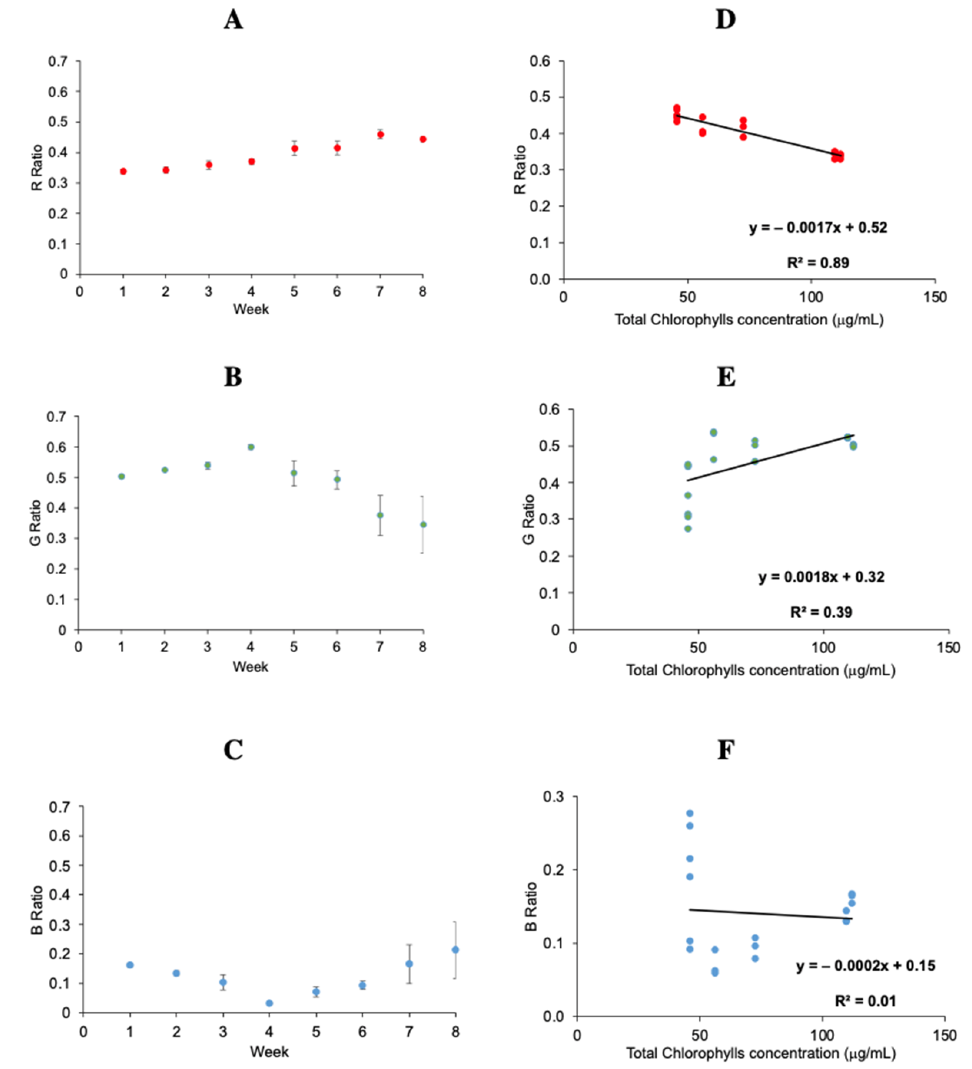
Figure 2. Evolution of the R, G and B ratios along the maturation stage ( A – C ) (mean ratio was obtained considering three replicates of samples (and three images per sample); and linear regression curves for R, G and B ratios and total chlorophyll concentration ( D – F ) (mean values were obtained considering three images per samples, and samples per week individually).